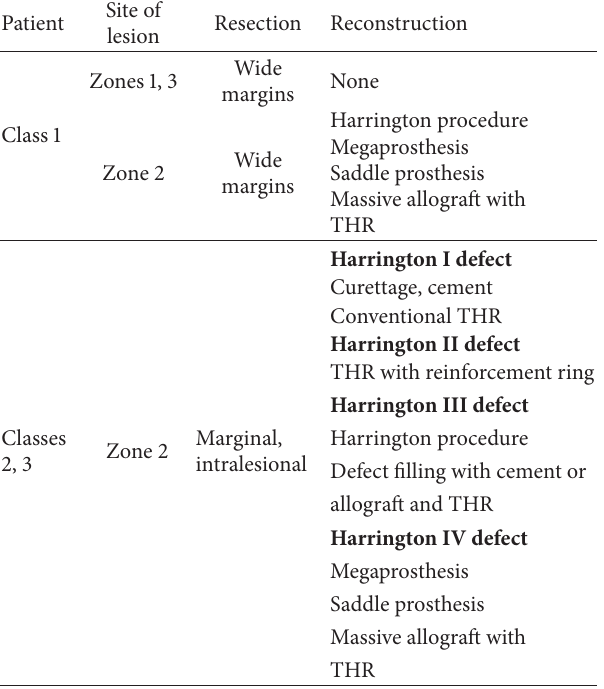
Table 2: Summary of surgical techniques for pelvic